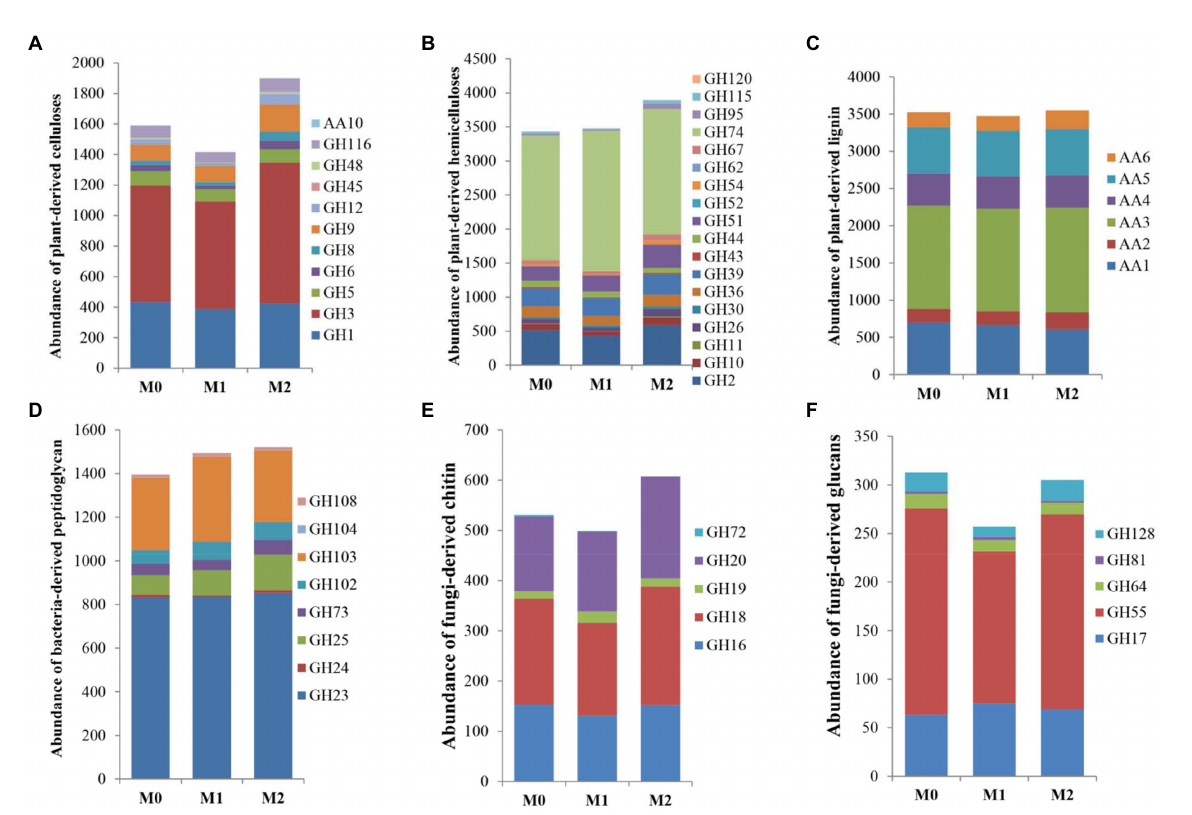
FIGURE 2 The abundance of selected GHs and AAs related to the degradation of the plant- and microbial- derived biomass in the bamboo plantations under different management practices. (A–C) plant-derived biomass decomposotion; (D) bacteria-derived biomass decomposition; (E,F) fungi-derived biomass